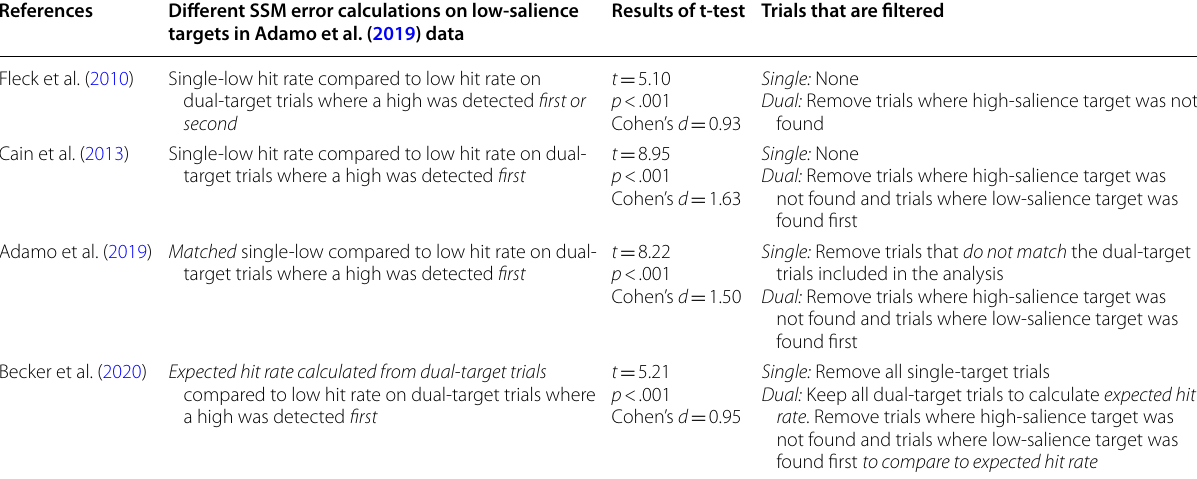
Table 2 SSM Effect Calculated Four Different Ways from the Same Data